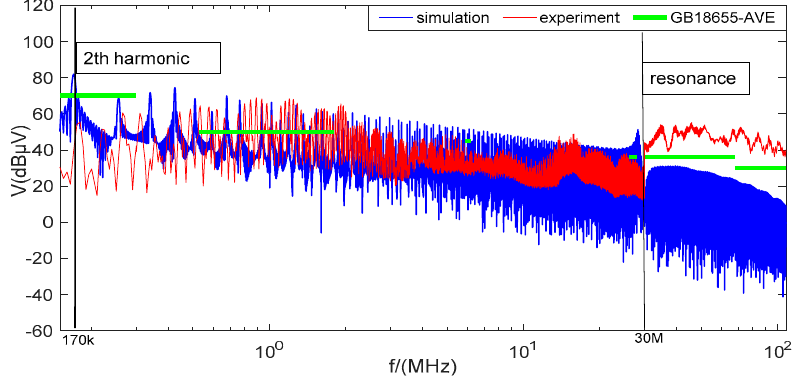
Figure 10. Comparison of simulation and experiment.